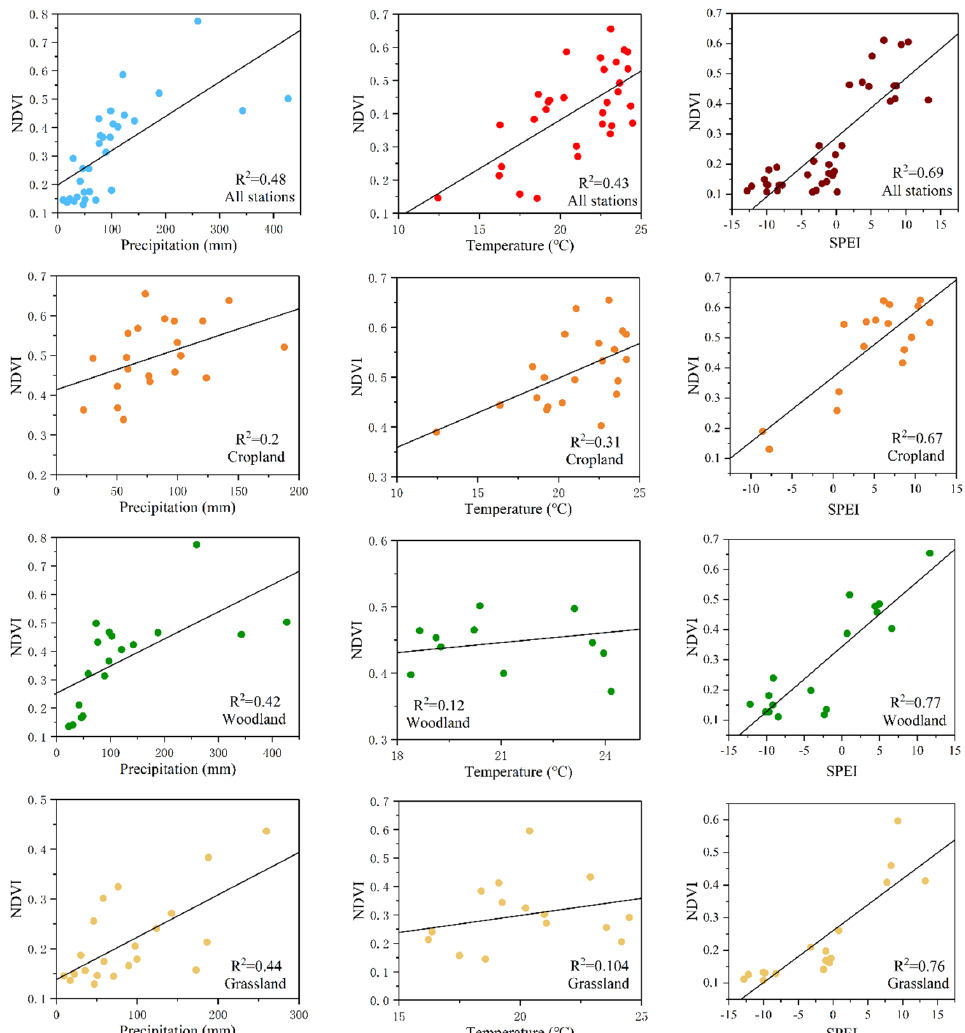
Figure 7. Correlations between the mean value of NDVI of three land use types and the mean annual total precipitation of meteorological stations, the mean annual mean temperature and SPEI during the 2000 − 2018 growing season in Xinjiang.